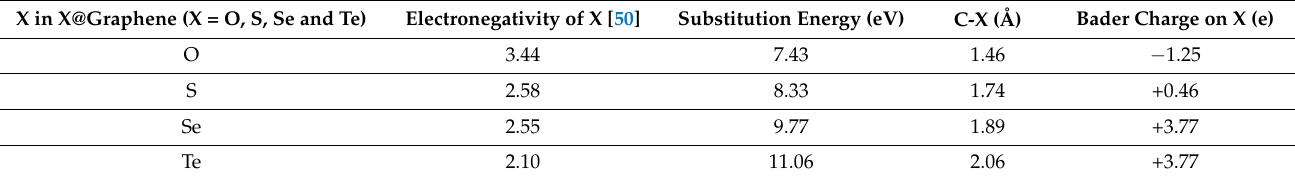
Table 5. Calculated substitution energies, Bader charges on the doped atoms, and bond distances